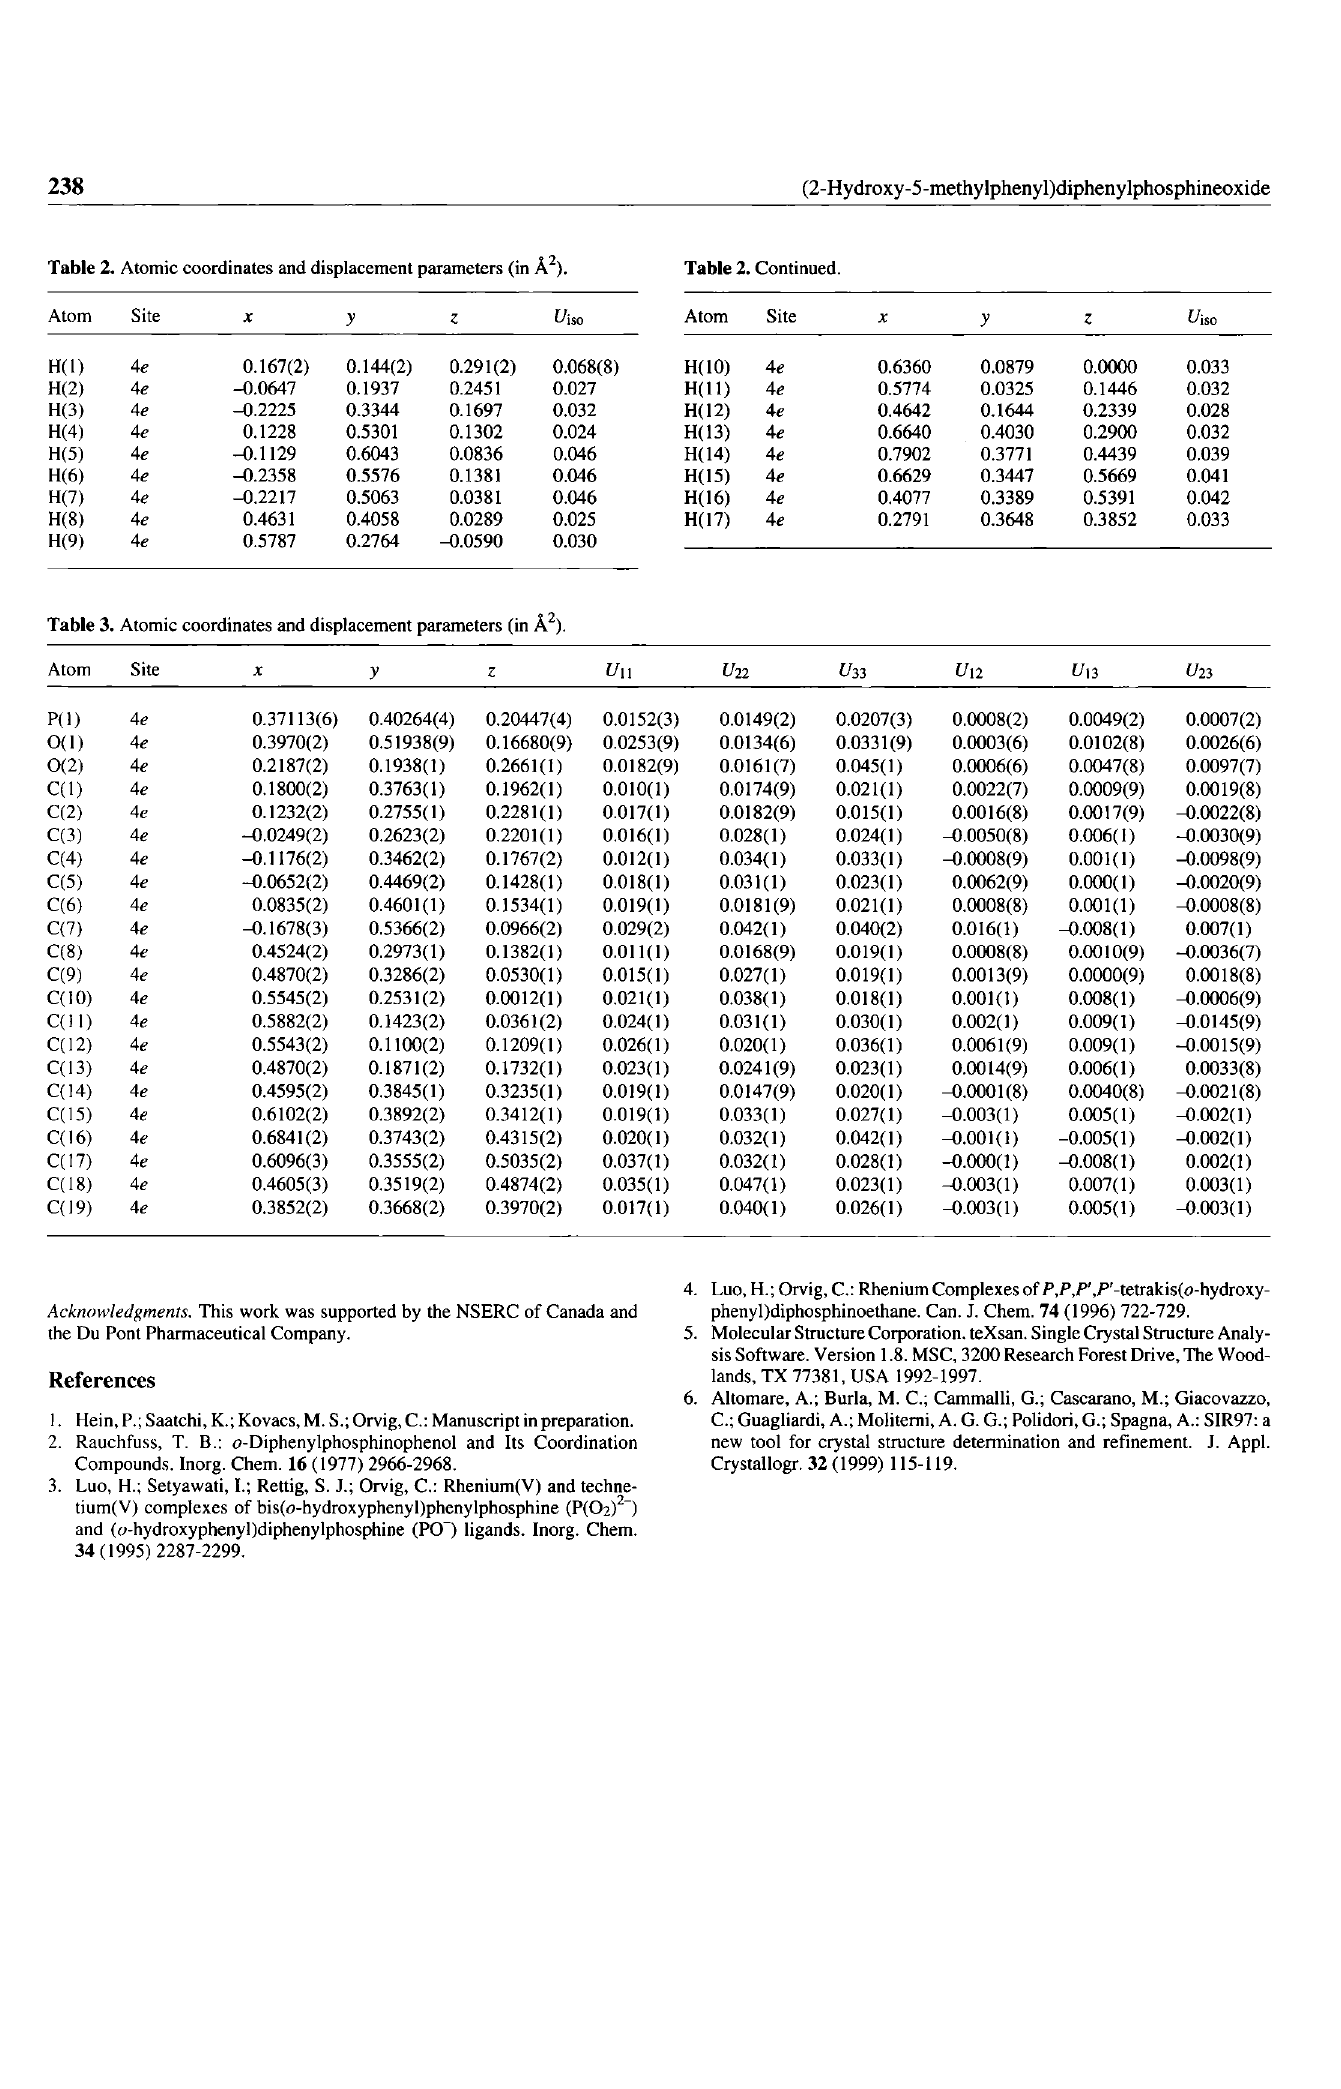
Table 3. Atomic coordinates and displacement parameters (in Ä 2